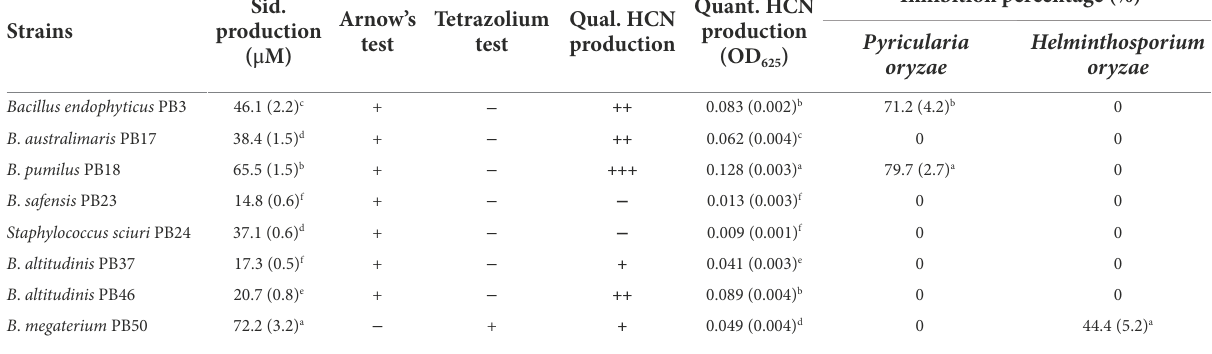
TABLE 2 Mean and standard deviation values of the indirect plant growth-promoting traits, such as siderophore (Sid.) production, qualitative (Qual.), and quantitative (Quant.) assessment of hydrogen cyanide (HCN) production, and growth inhibition of Pyricularia oryzae and Helminthosporium oryzae measured for each rice phyllosphere bacterial strain (number of replicates, n = 3).